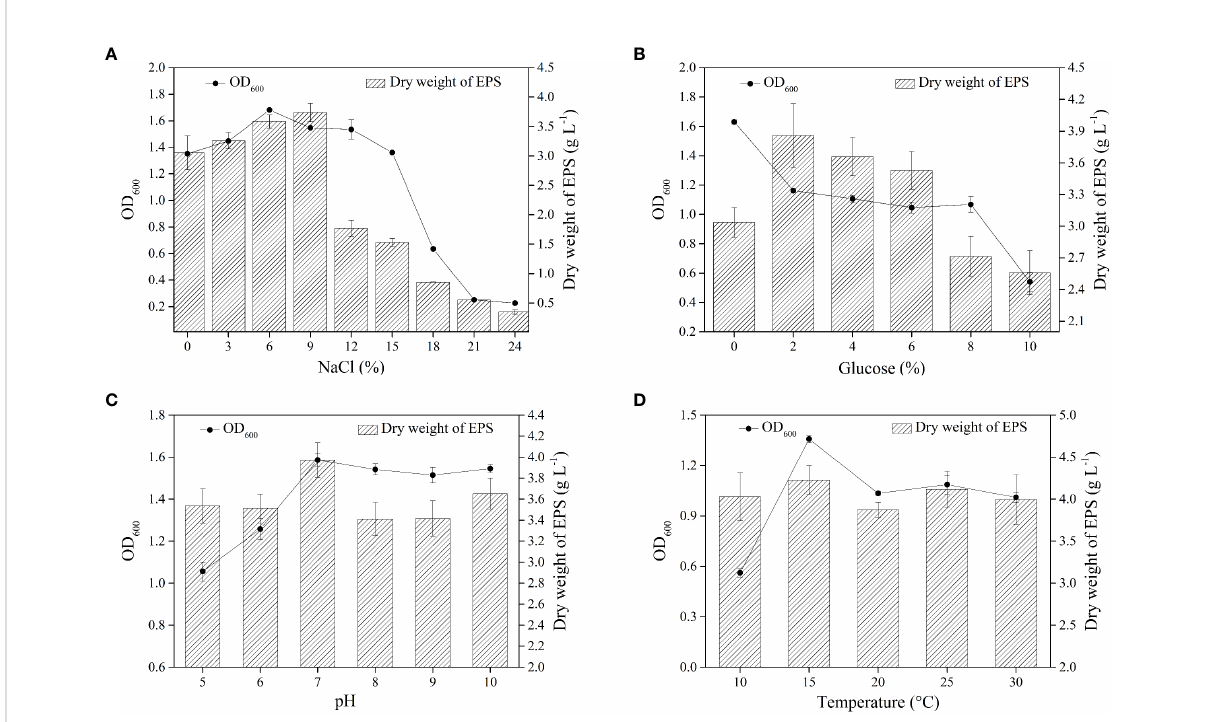
FIGURE 2 The effect of single factor optimization on EPS yield. The effect of NaCl on EPS yield at 25°C, 0% Nacl and pH=7 (A) The effect of glucose on EPS yield at 25°C, 9% NaCl and pH=7 (B) The effect of pH on EPS yield at 25°C, 9% NaCl and 2% glucose (C) The effect of pH on EPS yield at 9% NaCl, 2% glucose and pH =7 (D)